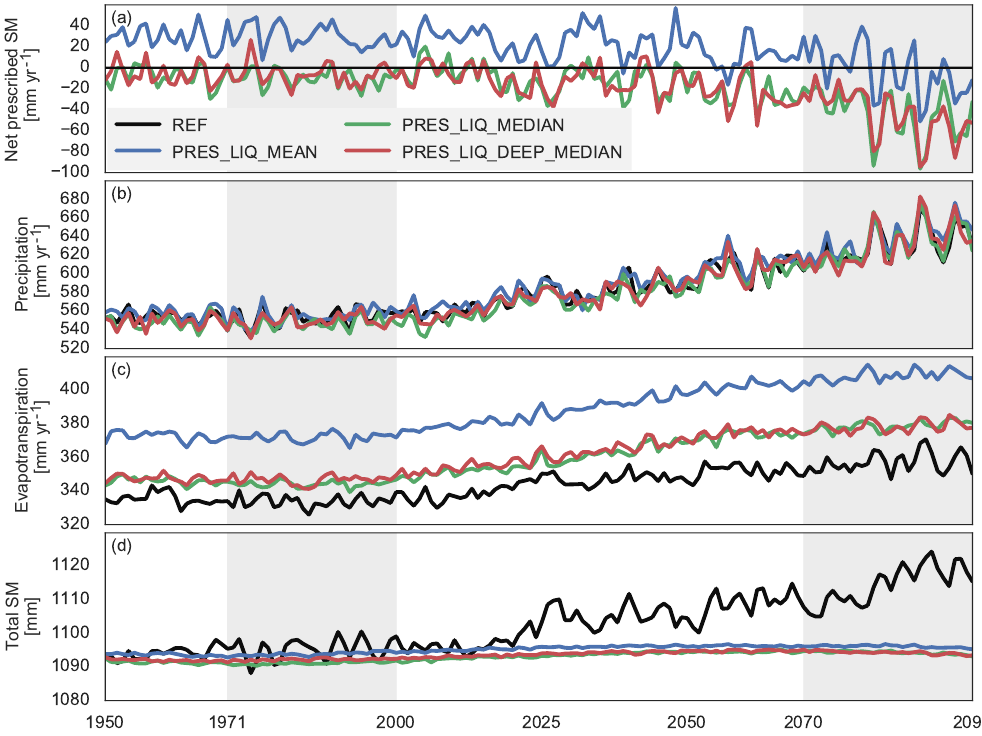
Figure 6. Time series of global-land, annual-mean (a) net-prescribed soil moisture, (b) precipitation, (c) evapotranspiration, and (d) total soil moisture content. Total soil moisture in the simulations with prescribed soil moisture is not entirely constant because ICE is still computed interactively. The light grey background shows the two time periods used for the